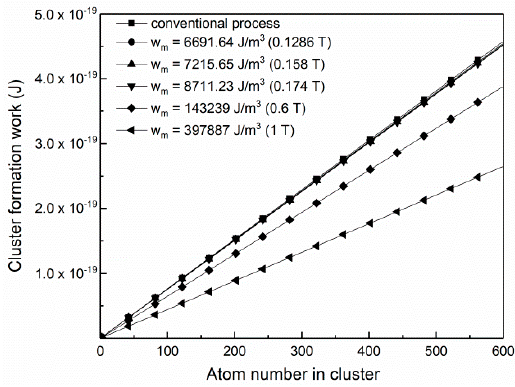
Figure 16. Effect of magnetic energy on the formation work of the cluster.